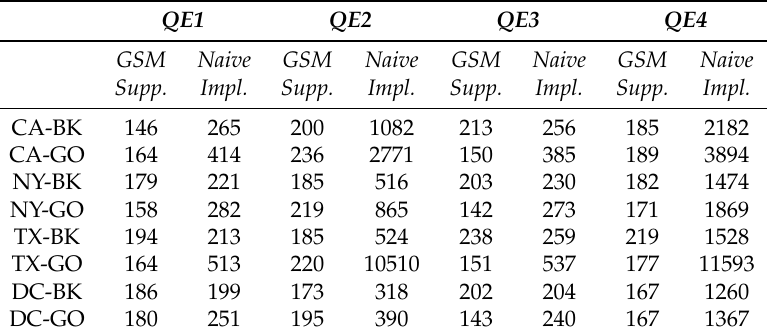
Table 4. Performance of queries (CPU time/ms).